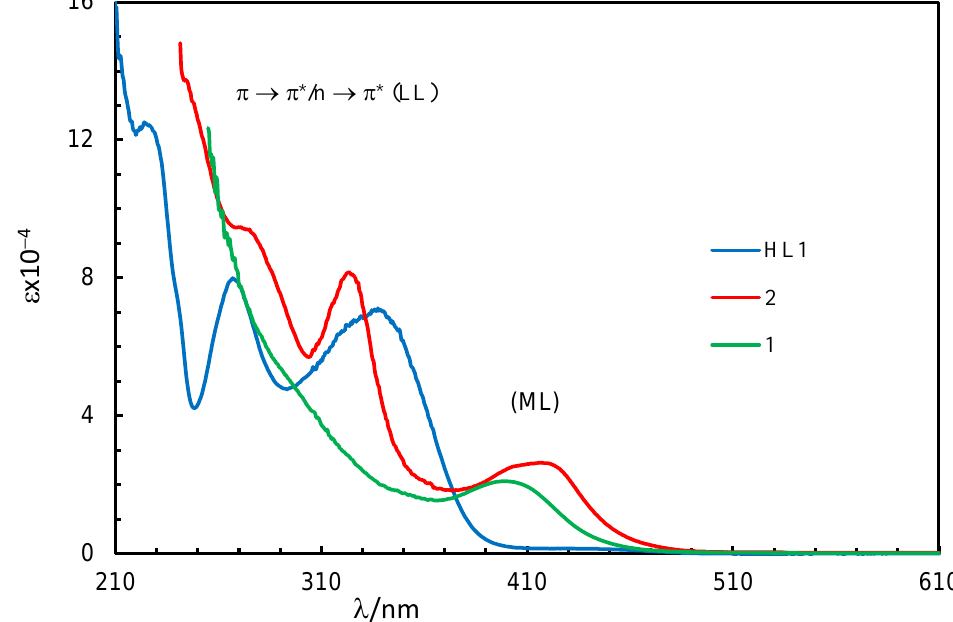
Figure 2. UV-Vis spectra for HL 1 (0.10 mM), 1 (0.20 mM) and 2 (0.08 mM) in chloroform at 25 °C.